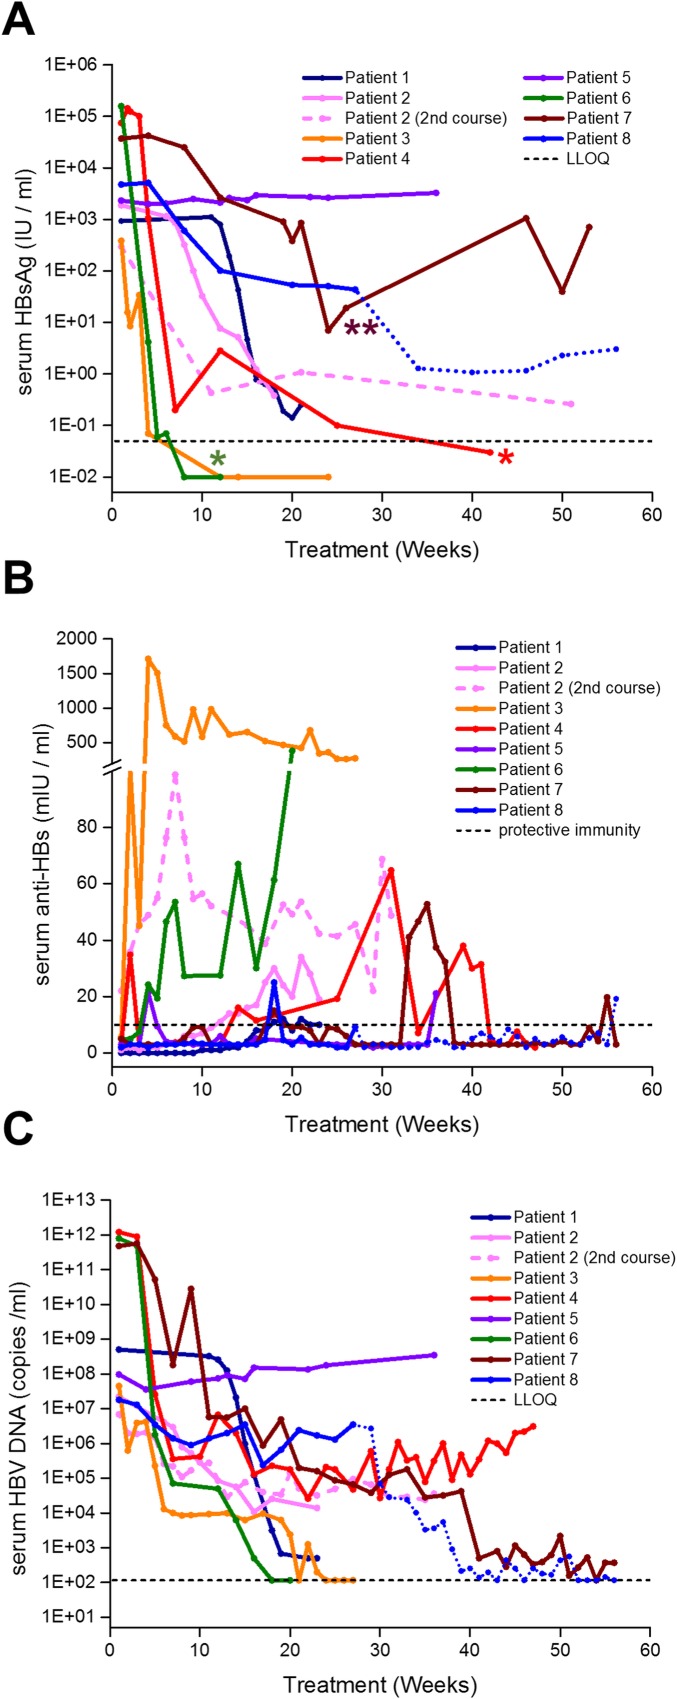
On-treatment antiviral response to REP 2055 monotherapy in patients admitted to the REP 101 protocol.Individual patient, colour coded antiviral responses to NAP monotherapy are shown for serum HBsAg (A), serum anti-HBs (B) and serum HBV DNA (C). LLOQ = lower limit of quantitation. Protective immunity = 10mIU / ml (as defined by the Architect® Assay). *serum HBsAg clearance in these patients until the end of REP 2055 treatment was established via the onsite qualitative HBsAg assay (see methods). ** = transient depression in serum HBsAg associated with increased frequency REP 2055 dosing. Dotted portion of lines for patient 8 in A, B and C indicate an additional 28 weeks of combination therapy with REP 2055 and ETV (see Results and Table 2).